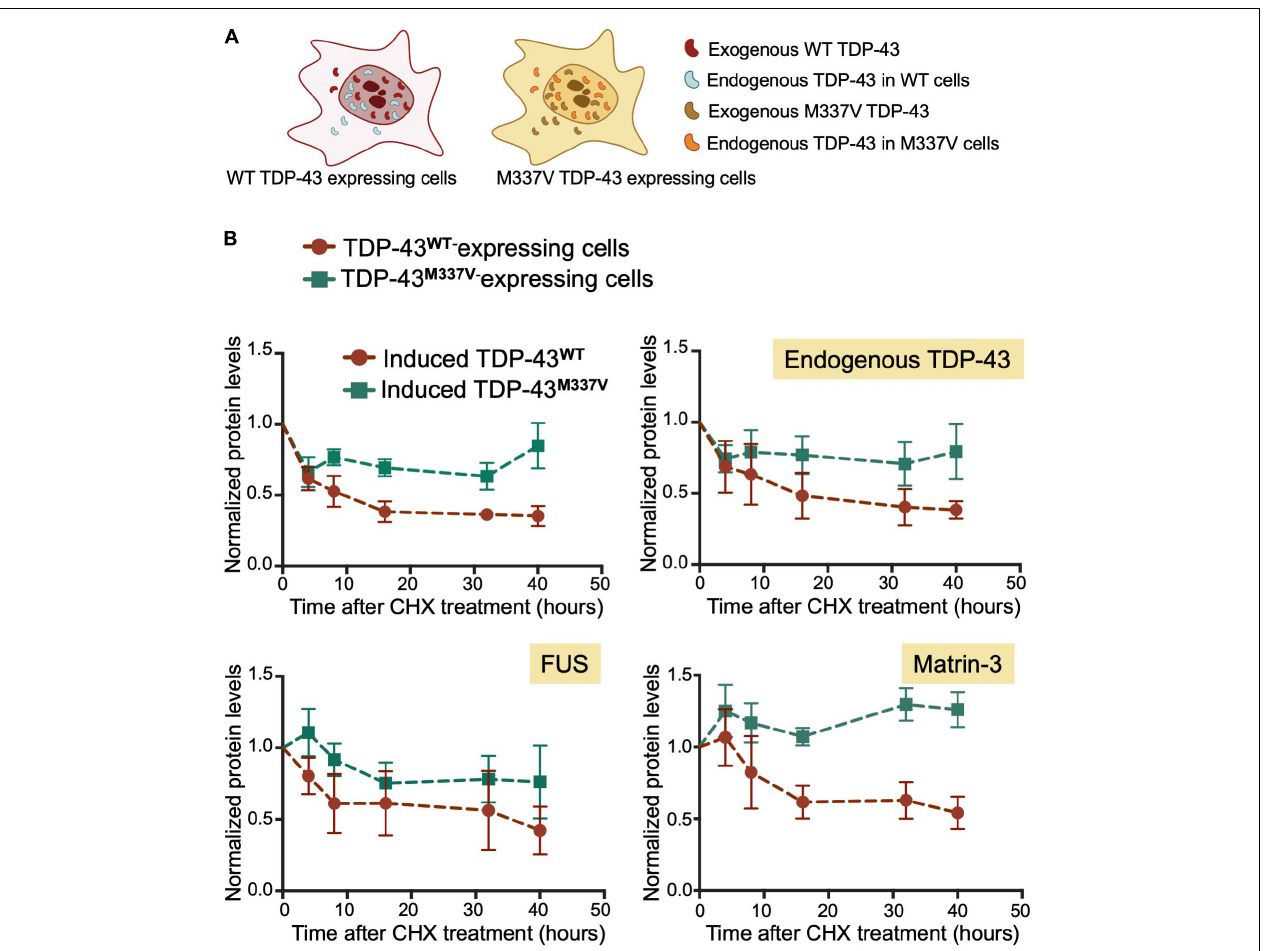
FIGURE 6 | M337V suppresses protein clearance of TDP-43 and other RNA binding proteins linked to ALS. (A) Cells stably expressing WT (red) or M337V (cyan) TDP-43 upon tetracycline induction in the presence of endogenous TDP-43. (B) Turnover of induced and endogenous TDP-43, FUS and matrin-3 monitored by measuring protein levels normalized to GAPDH at different time points post-cycloheximide (CHX) treatment (100 µ g/mL). Cells were treated with CHX after 72 h of induced transgene expression. Mean and SD of ≥ 3 biological